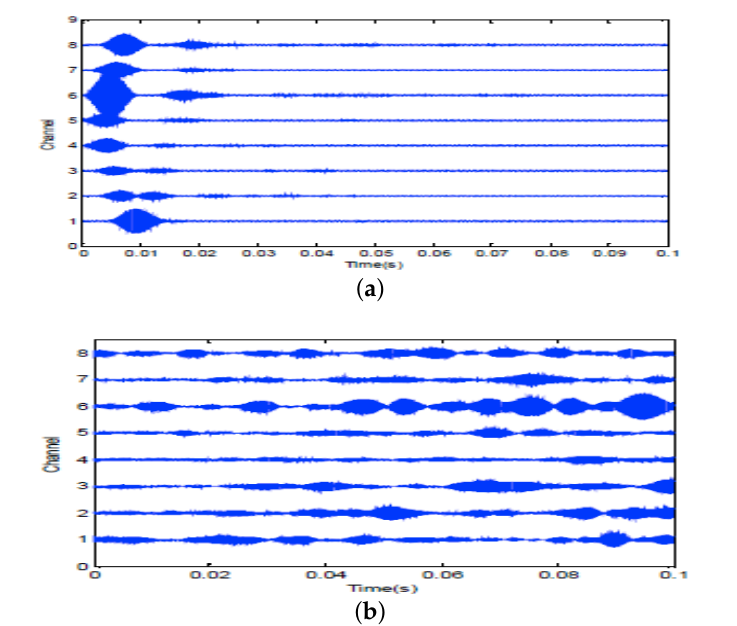
Figure 13. 7 kHz PCW signal: ( a ) echoes received by SRA1 after transmitting a probing signal; ( b ) the time-reversed signal for second transmission.